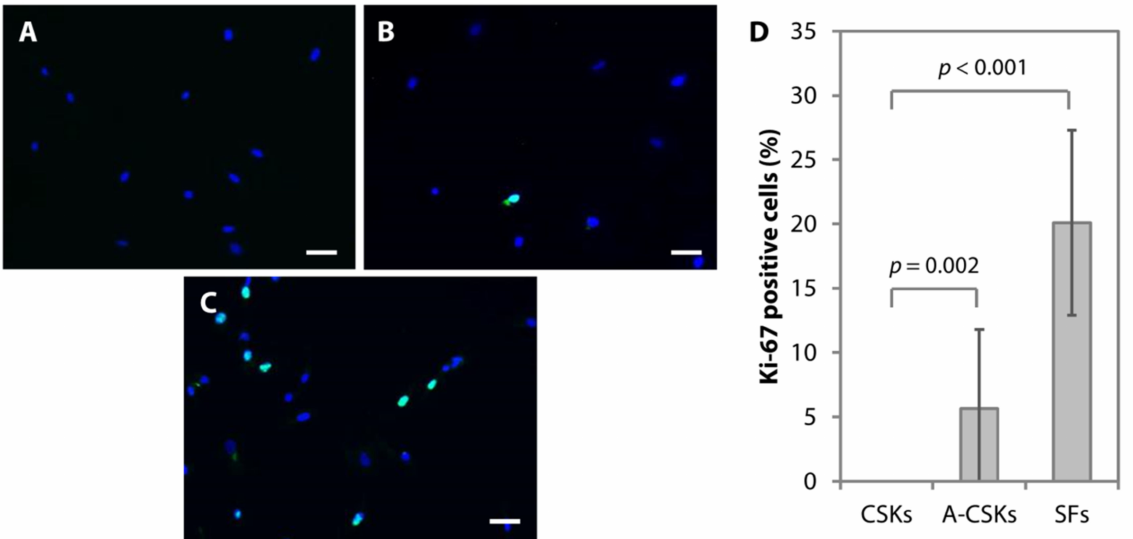
Figure 3. Proliferative capacity of corneal stromal keratocytes (CSKs), activated CSKs (A-CSKs), and stromal fibroblasts (SFs). The representative images of CSKs ( A ), A-CSKs ( B ), and SFs ( C ) were captured from cells at P5, which were expanded from the same donor. ( D ) The proliferative capacity (indicated by Ki-67-positive cells/total number of cells × 100%) of the A-CSKs was 5.6 ± 6.1%. On day 14, following medium switching to serum-free conditions, the proliferative capacity of CSKs was 0%. The SFs had a significantly higher proliferation rate of 20.1 ± 7.2% compared to both the CSKs ( p = 3.55 × 10 − 8 ) and the activated CSKs ( p = 3.78 × 10 − 5 ). Group comparisons were statistically determined using one-way ANOVA and Tukey comparison tests. Scale bars = 100 µ